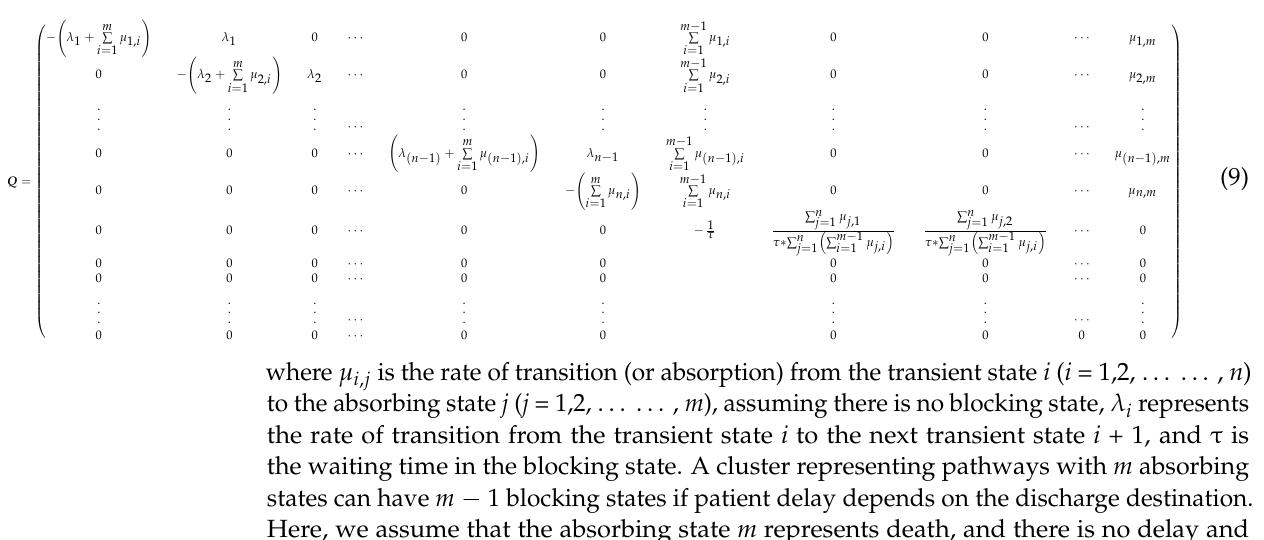
states can have m − 1 blocking states if patient delay depends on the discharge